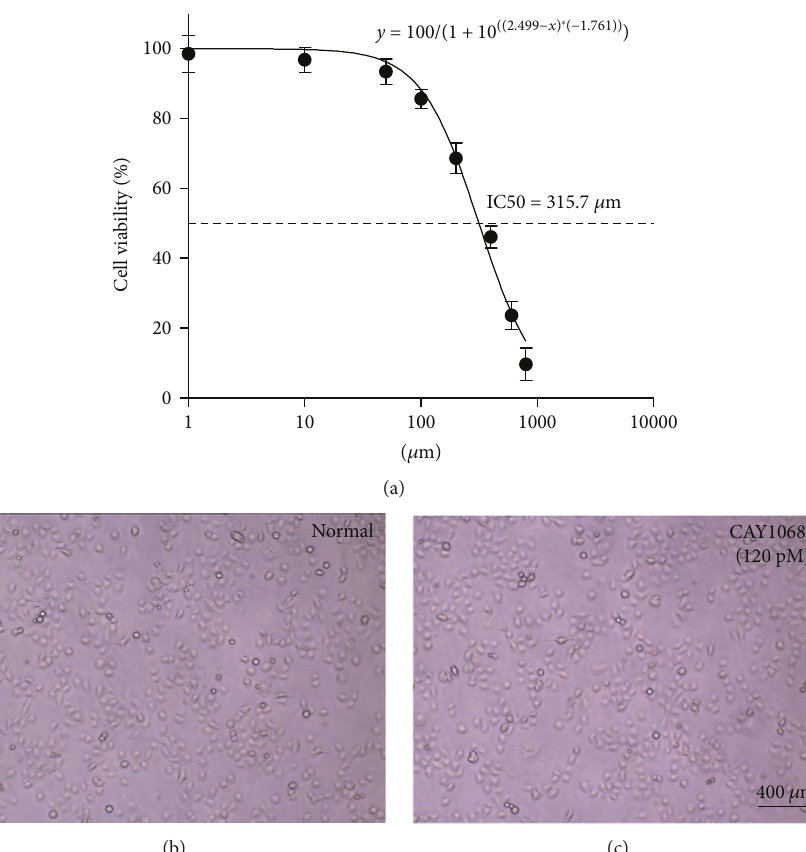
Figure 1: (a) Detection of cell proliferation activity by CCK-8. (b – c) Cell morphology was observed in normal and CAY10683-treated NCM460 cell group. Values are expressed as mean ± SD. P < 0 05 , compared with normal group; P < 0 05 , compared with model